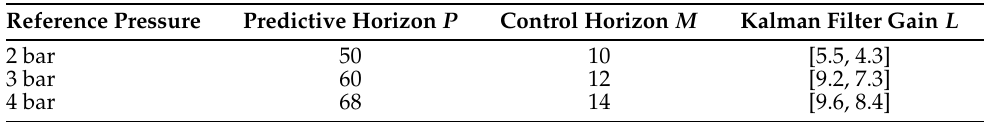
Table 2. Parameters for the simulation with the MPC controller under different reference pressure